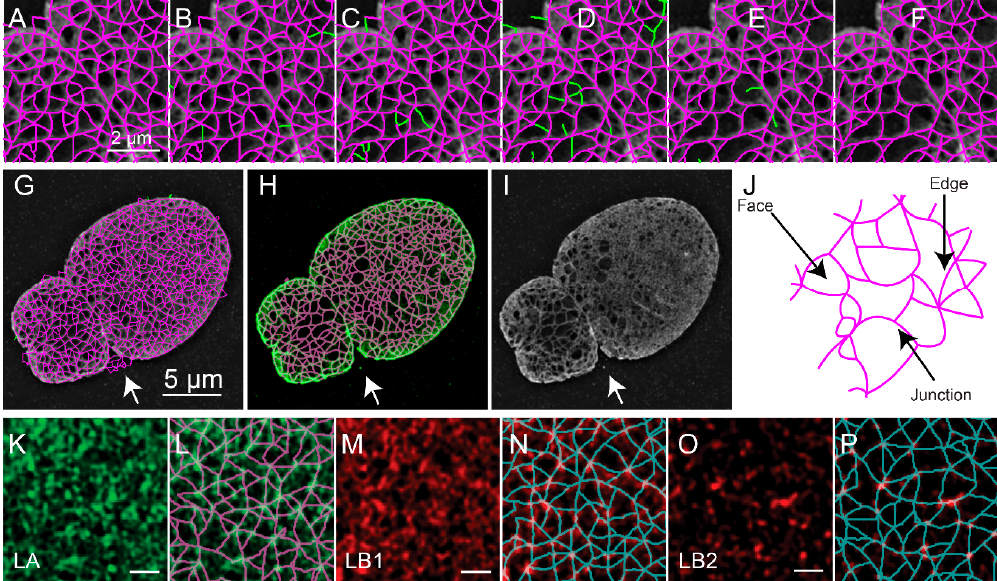
Figure 5. Edge and Face Based Auditing of Meshwork Structure of a SIM Image of a Lmnb1 -/- MEF. Unaudited edges are drawn as magenta lines over reconstructed image of the region in the white box indicated in Figure 1C ( A ). Edges are audited in a multistep process to remove edges which do not match features in the reconstructed image. First, edges (green) are removed due to the edges not matching the ratio image based on a distance weighted intensity measurement ( B ). Then, edges (green) are removed since either the minimum intensity, mean intensity, or normalized range of intensities in the reconstructed image (Figure 1C) do not meet thresholds described in the text ( C ). Next, edges (green) are removed since the edges do not sufficiently overlap the ratio image (Figure 1E) above an Otsu threshold ( D ). Finally, edges (green) are removed ( E ) since the new areas that result, faces as in ( J ) would better match the ratio image based on a distance weighted intensity measurement ( F ). These steps result in an audited meshwork shown in magenta (F). A zoomed-out view ( G ) of the entire unaudited meshwork is drawn as magenta lines over the reconstructed image. Green lines in (G) indicate edges not adjacent to faces being removed in early auditing steps. The audited meshwork drawn as magenta lines is superimposed on the reconstructed image intensity in green ( H ). The reconstructed image intensity as in Figure 1C is shown for comparison ( I ). The meshwork results in faces, edges, and junctions (J), whose properties have been quantified for further analysis [10] . Edges are lines tracing fibers of the nuclear lamina. Junctions are lines where multiple edges meet. Faces are enclosed areas surrounded by edges. The meshwork analysis has been applied to 3D-SIM images in dense Lamin A ( K,L ), Lamin B1 ( M,N ), and Lamin B2 ( O,P ) [10] . The white scale bar indicates two micrometers (A–F), five micrometers (G–I), or one micrometer (K–P). The figure has been adapted from portions of Shimi and Kittisopikul et al.